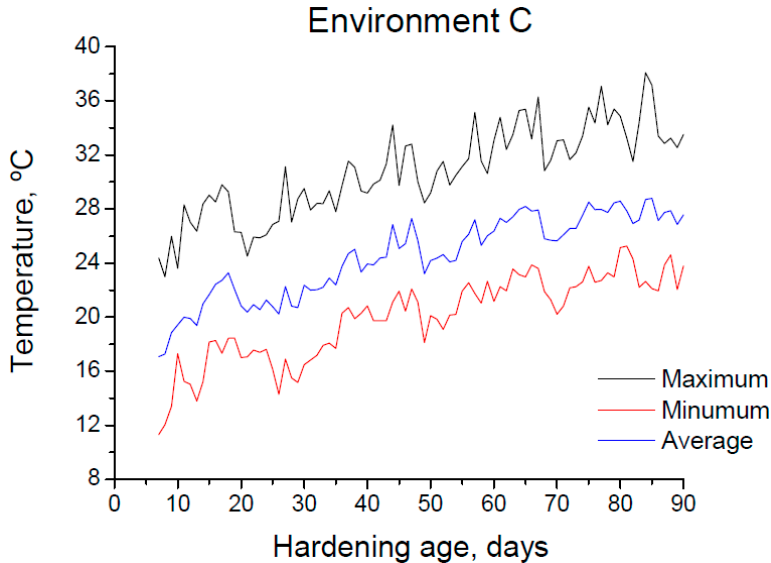
Figure 3. Daily maximum, minimum and average temperature registered in the station throughout the 90-day period of exposure to environment C.